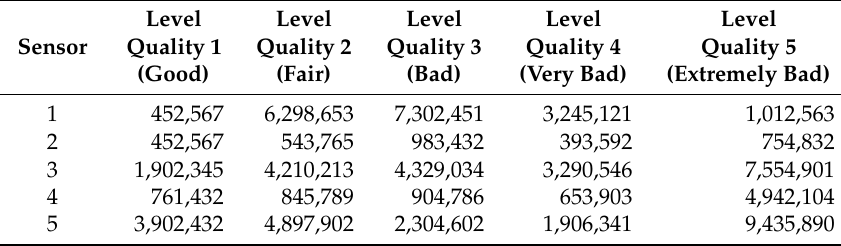
Table 3. The frequency matrix of Quality levels with five sensors.